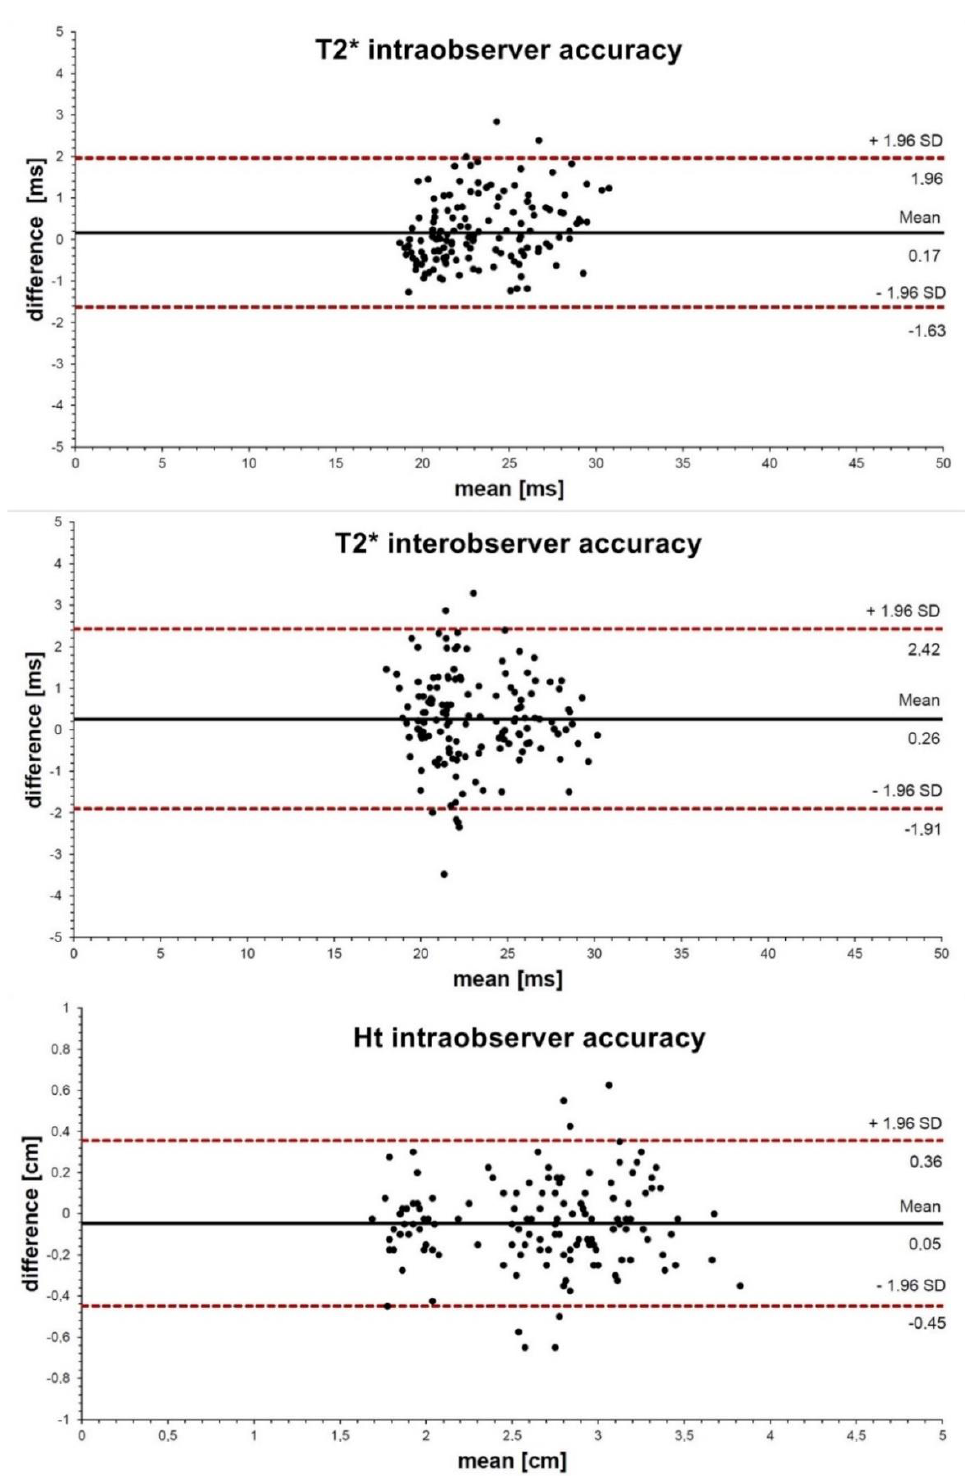
Figure 2. Bland–Altman Plot for Measured Cartilage T2* and Ht: intra- and interobserver accuracy (black line: mean), with 95% limits of agreement (LOA: dotted red lines: mean difference ± 1.96 SD). At baseline, the mean measured Ht in the FPJ was greater compared to that in the FTJ. Compared to baseline, the after-load measurements in the FPJ and FTJ showed a slightly lower Ht in the majority of the measurement series (cartilage segments, Table S1 in the Supplementary Files). The SD of the measured changes in cartilage height Ht was regularly below 0.22 mm (Table S1 in the Supplementary Files).